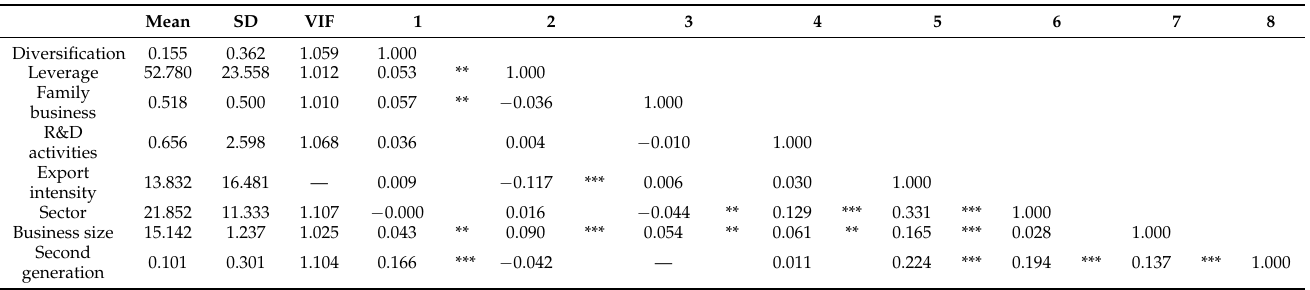
Table 3. Descriptive statistics and Correlation Matrix. Internationalization Starting from Local Market.